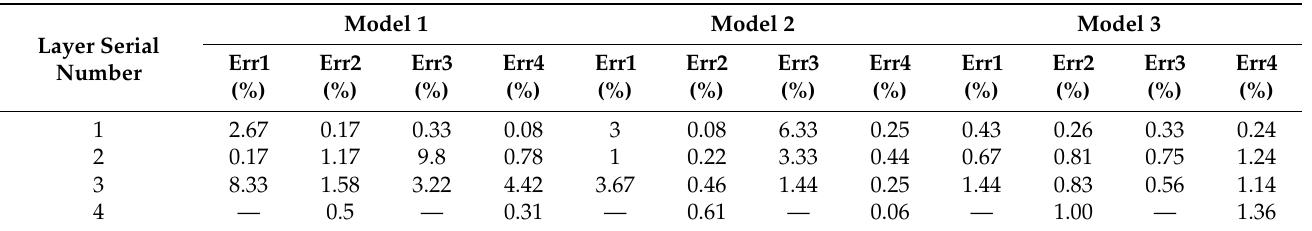
Table 3. Relative errors between the results of different inversion objective functions and the real model.